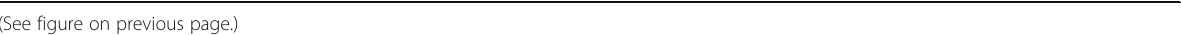
the Z3 transgene and confirmed all six independent T transgenic plants (Additional file 4: figure S4a). Overex- pression of Z3 by the CaMV 35S promoter in the trans- genic lines was validated by semi-quantitative RT-PCR (Additional file 4: figure S4b). The six complementation lines ( 35S:Z3 / z3 ) grew normally at the early vegetative stage uren contrast to the inferior growth of the z3 mutant (data not shown), and flowered as early as the wild type (Fig. 5a), indicating that constitutive expression of Z3 complemented the late-flowering phenotype of the z3 mutants under NLD conditions in the field. Moreover, the leaf and grain phenotypes of these six complementation lines were indistinguishable from those of the wild-type plants (Fig. 5b – d), confirming that the leaf variegation and seed discoloration phenotypes of the z3 mutant results from the missense mutation in Z3 (S542).